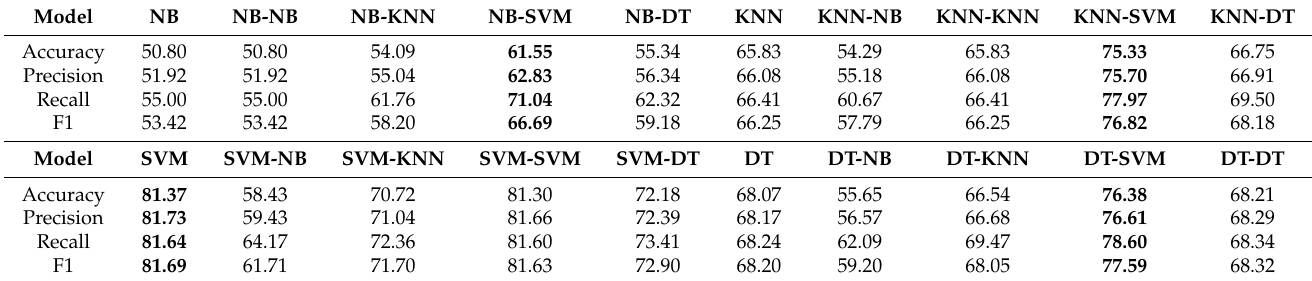
Table 4. Recognition performance on the Gyroscope dataset.